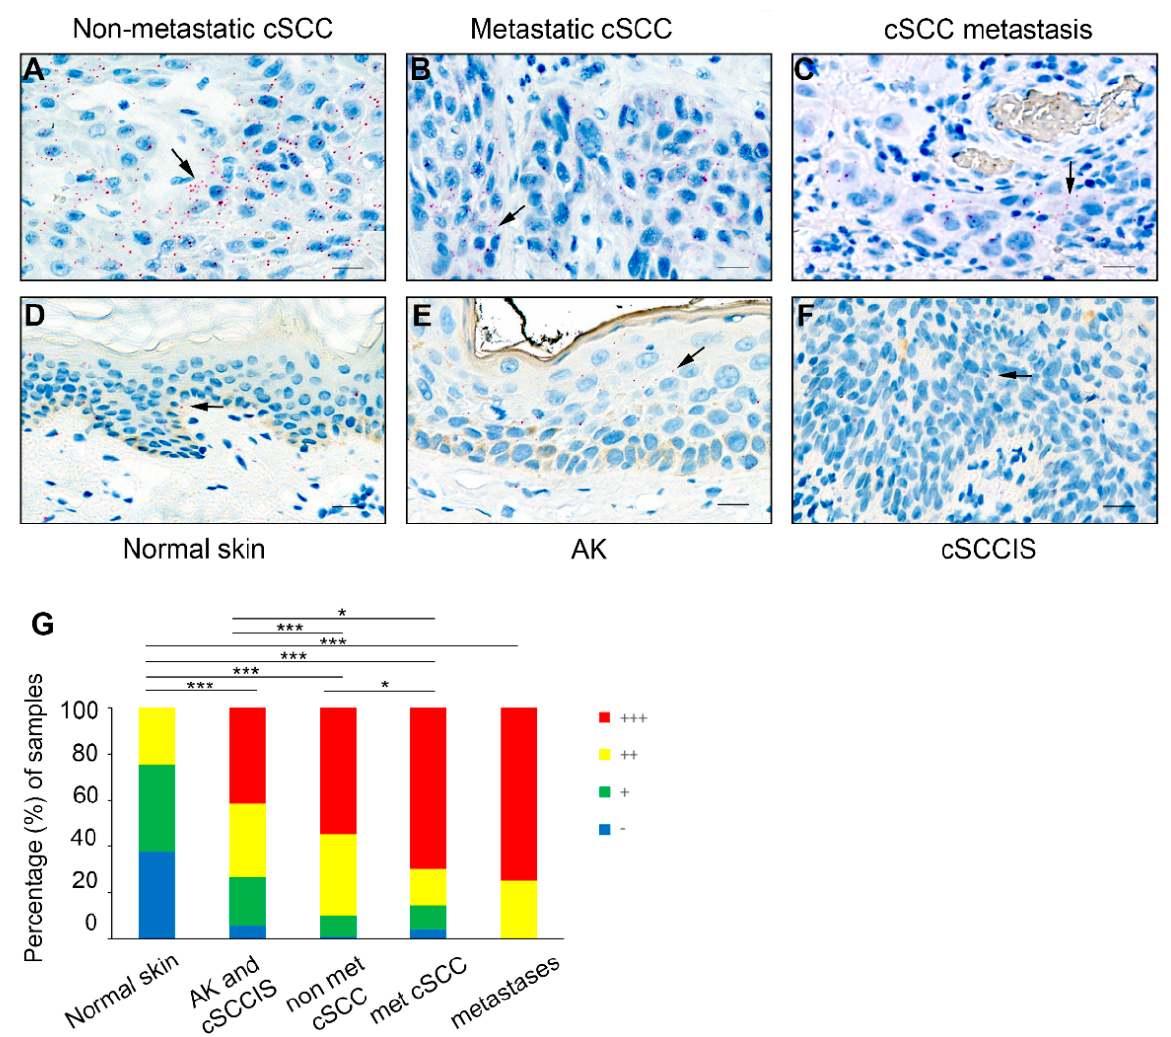
Figure 2. Expression of BRD3OS ( LINC00094 ) in cSCC tumor cells in vivo. ( A – F ) RNA in situ hybridization (RNA-ISH) expression of BRD3OS ( LINC00094 ) in tissue sections. ( A ) UV-induced primary non-metastatic invasive cSCC ( n = 119), ( B ) primary metastatic cSCC ( n = 76), ( C ) cSCC metastasis ( n = 8), ( D ) normal skin ( n = 24), ( E ) actinic keratosis (AK; n = 67) and ( F ) cSCC in situ (cSCCIS; n = 60). In invasive non-metastatic cSCCs ( A ), primary metastatic cSCCs ( B ), and cSCC metastases ( C ), the expression of mainly cytoplasmic BRD3OS ( LINC00094 ) was stronger than in normal skin ( D ), AKs ( E ) or cSCCISs ( F ). Arrows illustrate the BRD3OS ( LINC00094 ) positive spots in cells. Scale bar = 20 µm. ( G ) The expression of BRD3OS ( LINC00094 ) was classified as negative ( − ), weak (+), moderate (++), and strong (+++) according to the extensity and number of positive spots in cells. * p < 0.05, *** p < 0.001 by two-tailed X 2 or Fisher’s exact test. BRD3OS ( LINC00094 ) expression was scored as negative ( − ) when single particles were detected in single cells, weak positive (+) when single particles were noted in several cells, moderate positive (++) when two particles were detected in several cells and strong positive (+++) when more than two particles were detected in cell cytoplasm or nuclei scattered widely in samples. The analysis showed that there was no strong (more than two particles in cell) (+++) expression of BRD3OS ( LINC00094 ) in normal skin samples (0% of cases), and the strong (+++) positive expression was noted significantly more in premalignant lesions (AK and cSCCIS) (42% of cases), invasive primary non-metastatic cSCCs (55%), primary metastatic cSCCs (70%), and cSCC metastases (75%) than in normal skin (0%) (Figure 2G). In addition, there were significantly less BRD3OS ( LINC00094 ) positivity in AKs and cSCCISs compared to non-metastatic cSCCs and metastatic cSCCs but more than in normal skin (Figure 2G). Furthermore, significantly stronger expression